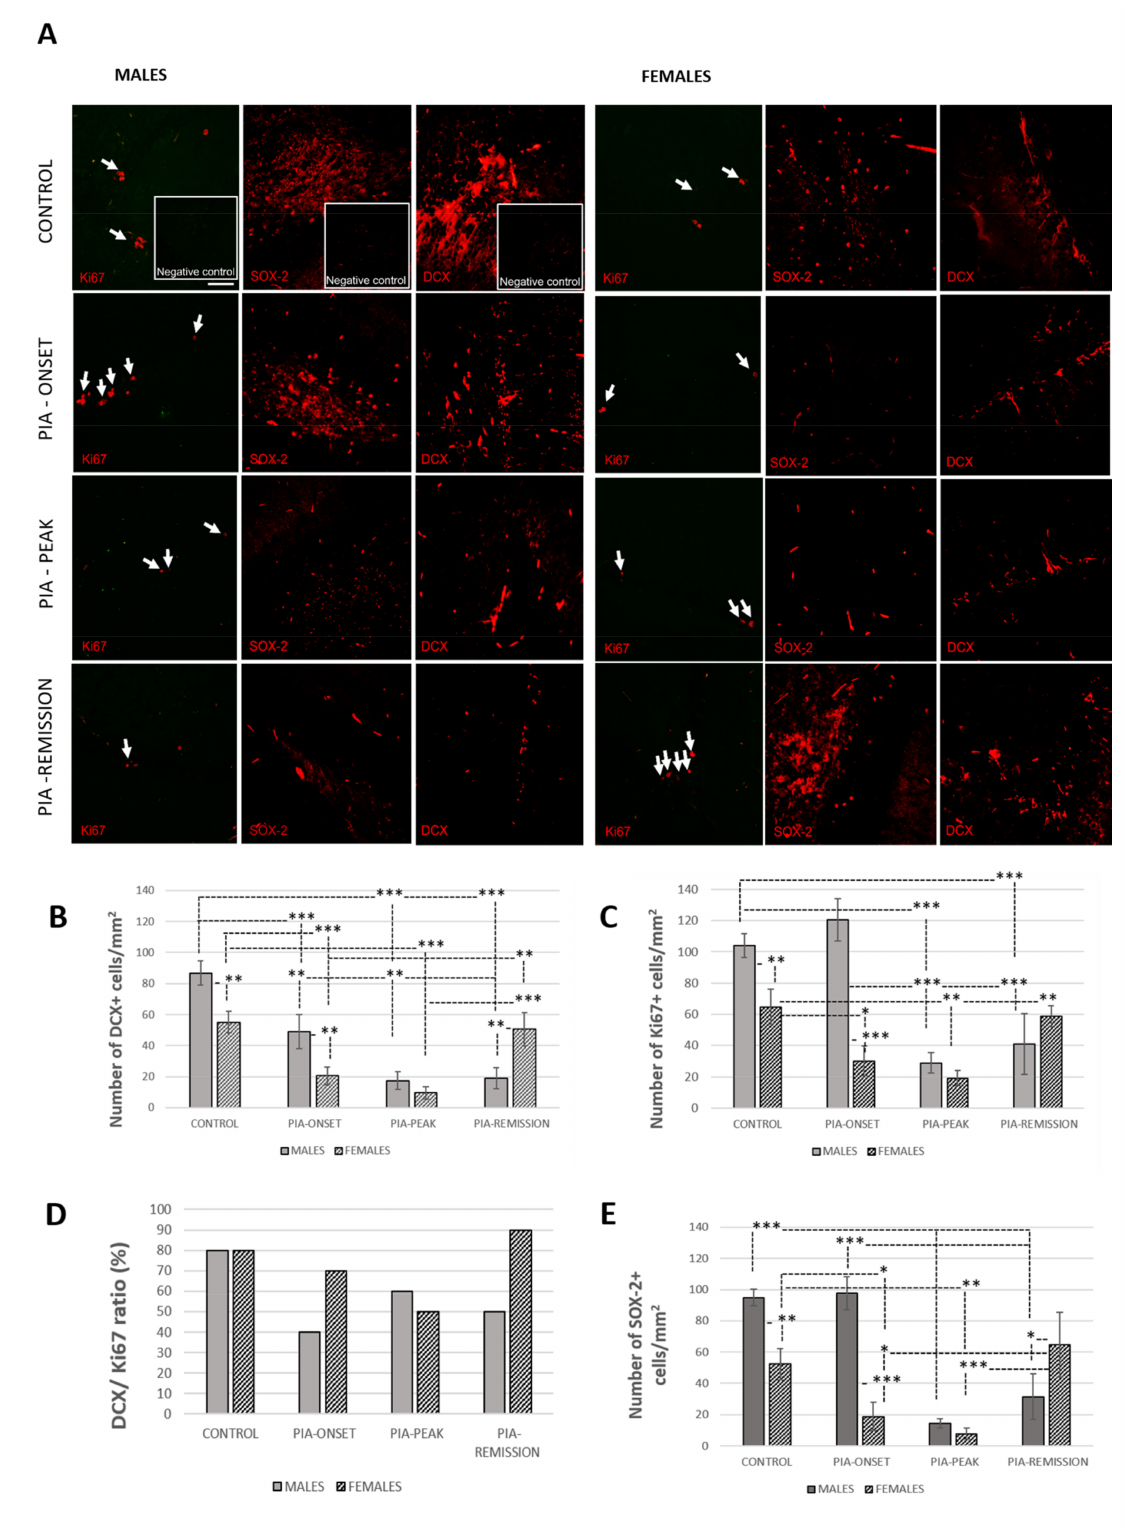
Figure 2. Pristane-induced arthritis downregulates the number of Ki67 + , DCX + , and SOX-2 + cells as well as the DCX/Ki67 ratio in DA rats. ( A ) Representative immunofluorescent pictures show staining with anti-Ki67, anti-DCX, and anti-SOX-2 antibodies in paraffin-embedded sections of brain tissue obtained from male and female DA rats: control (treated with saline); PIA